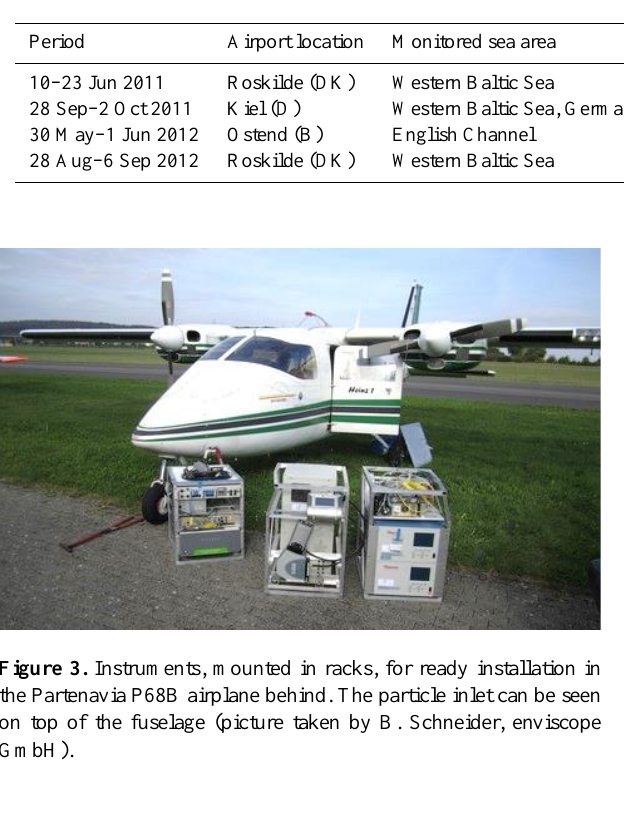
Table 1. Description of the airborne measurement campaigns. Measurement flights were conducted on 25 days within these periods.